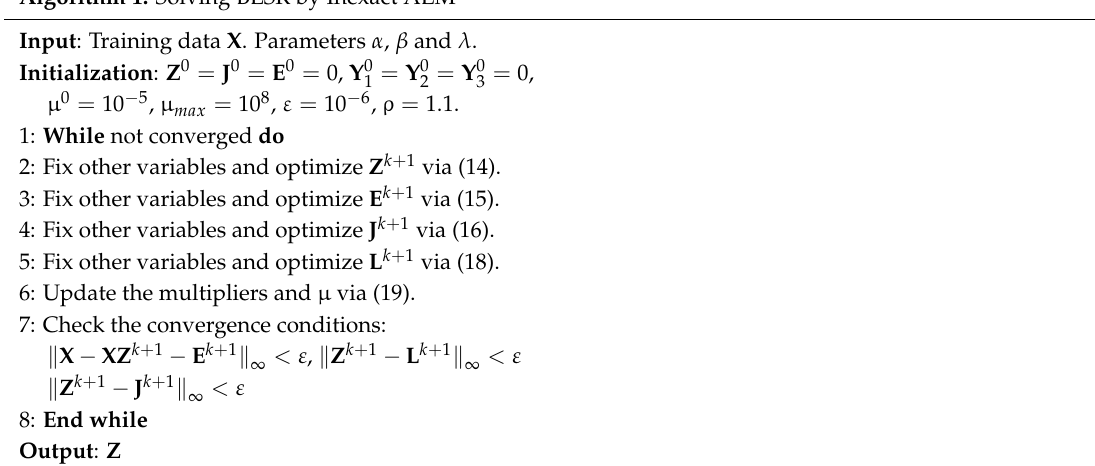
Algorithm 1. Solving BLSR by Inexact